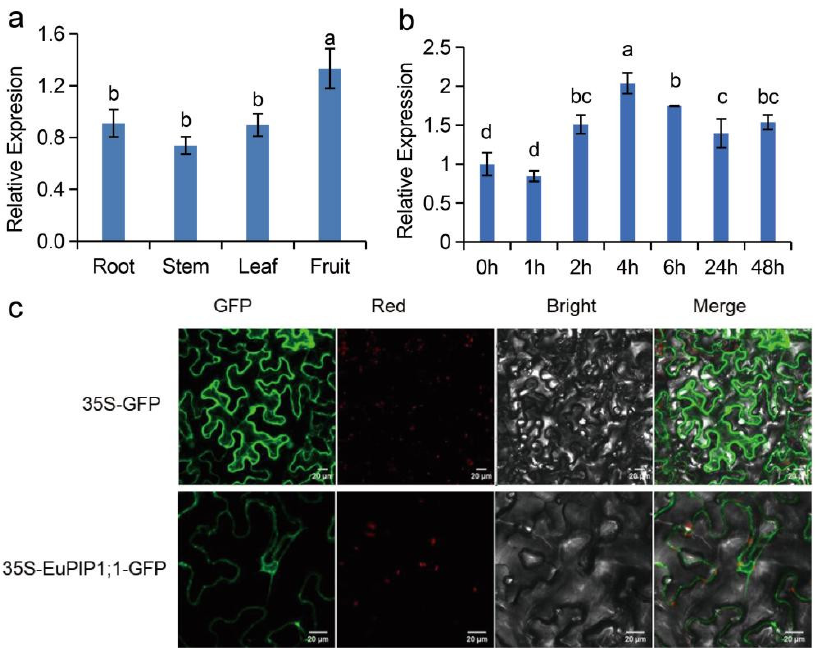
Figure 3. The expression pattern of EuPIP1;1 and the subcellular localization of the EuPIP1;1 protein. ( a ) Tissue-specific expression of EuPIP1;1 . ( b ) Relative transcript levels of EuPIP1;1 in leaves of E. ulmoides treated with 20% PEG6000 for different time. ( c ) Subcellular localization of EuPIP1;1 in epidermal cells of tobacco leaves. Significant differences were determined by one way ANOVA followed by Duncan’s multiple range test at p < 0.05.